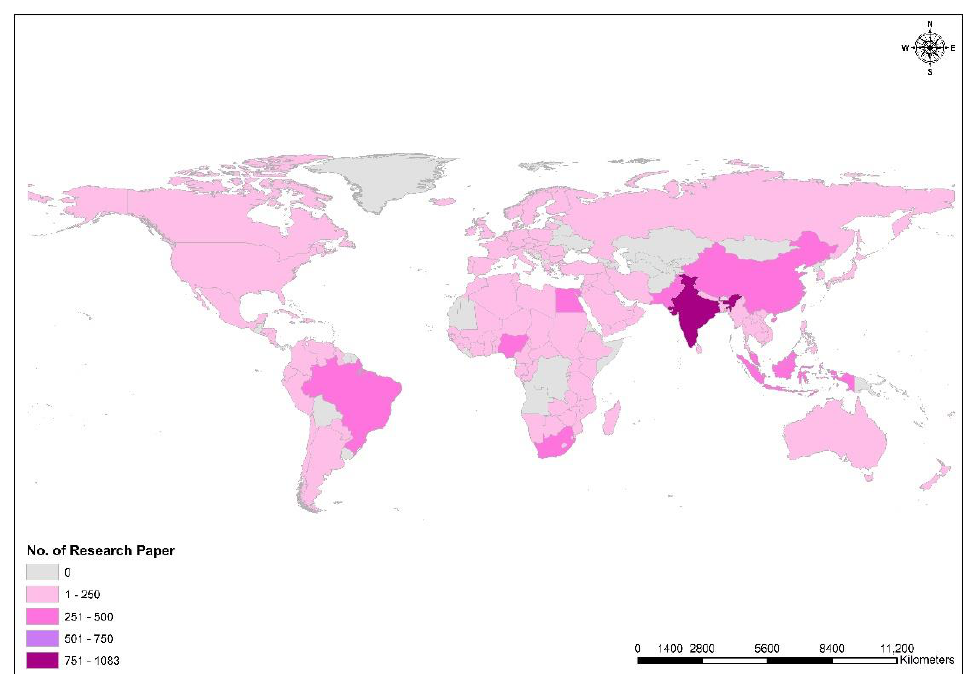
Figure 1. ArcGIS 10.1-based spatial distribution map highlights research papers published on M. oleifera worldwide. A spatial technique was used to generate a map, and GIS layers were obtained from DIVA-GIS, an open-source web platform.